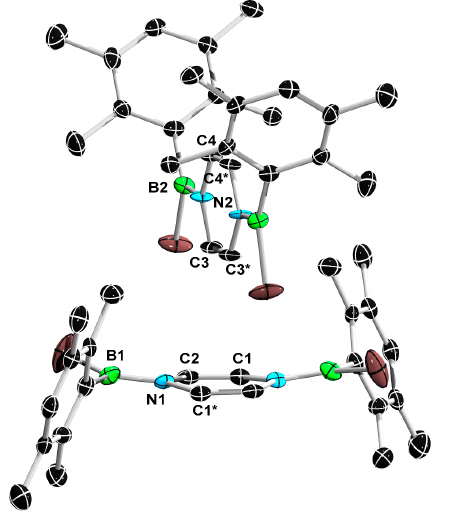
Figure 1. Molecular structures of 5a (bottom) and 5b (top) in the solid state (ellipsoids set at 50% probability). Hydrogen atoms are omitted for clarity. Selected bond lengths (Å) and angles (°) for 5a :